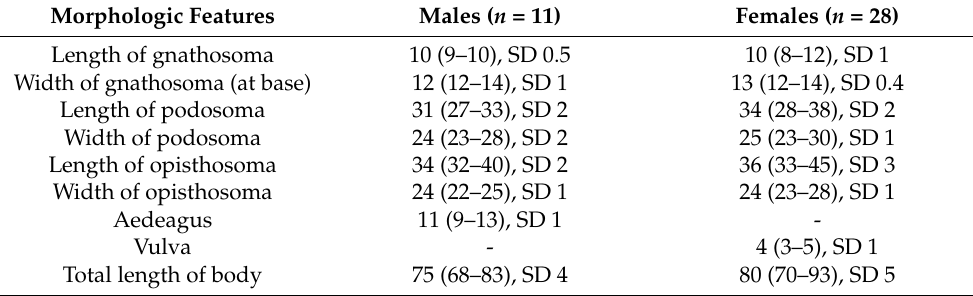
Table 1. Body size (mean, range and SD, in µ m) for adults of Demodex pusillus sp. nov. Morphologic